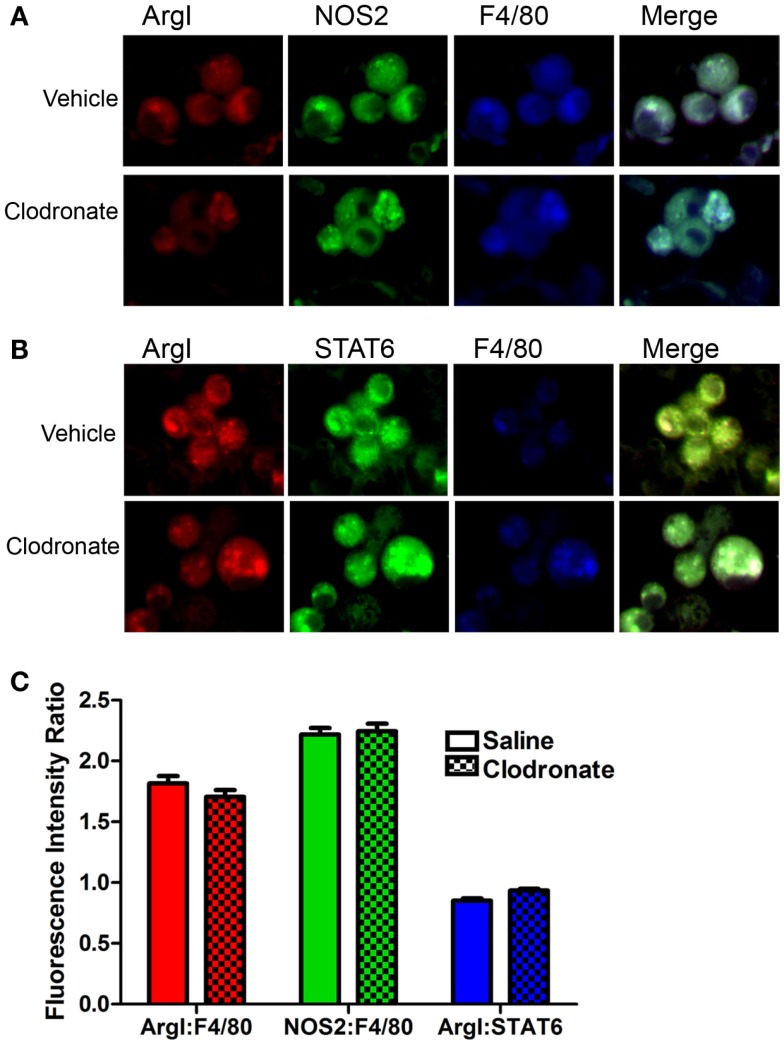
Immunofluorescent determination of macrophage programing. (A) Alveolar macrophage ArgI (red), NOS2 (green), and F4/80 (blue) expression and the merged image (showing co-localization) in tumor-bearing mice treated with saline or clodronate-containing liposomes. (B) ArgI (red), STAT6 (green), and F4/80 (blue) expression and the merged image showing co-localization in tumor-bearing mouse lung treated with saline or clodronate-containing liposomes. (C) Pixel counts/macrophage of ArgI (red) or NOS2 (green) normalized to F4/80 (blue) or STAT6 (blue)/ArgI ratios in saline (open bars) or clodronate (cross-hatched) liposome-treated lung (mean ± SEM, n = 135–150 macrophages/group).